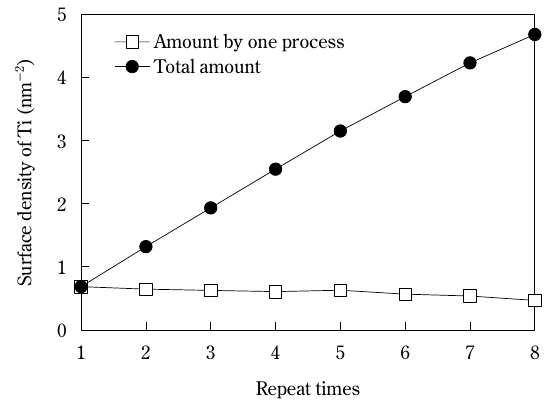
The relationship between repetitions and surface density of Ti; (cid:2) indicates the amount from each process while (cid:3) is the total accumulated